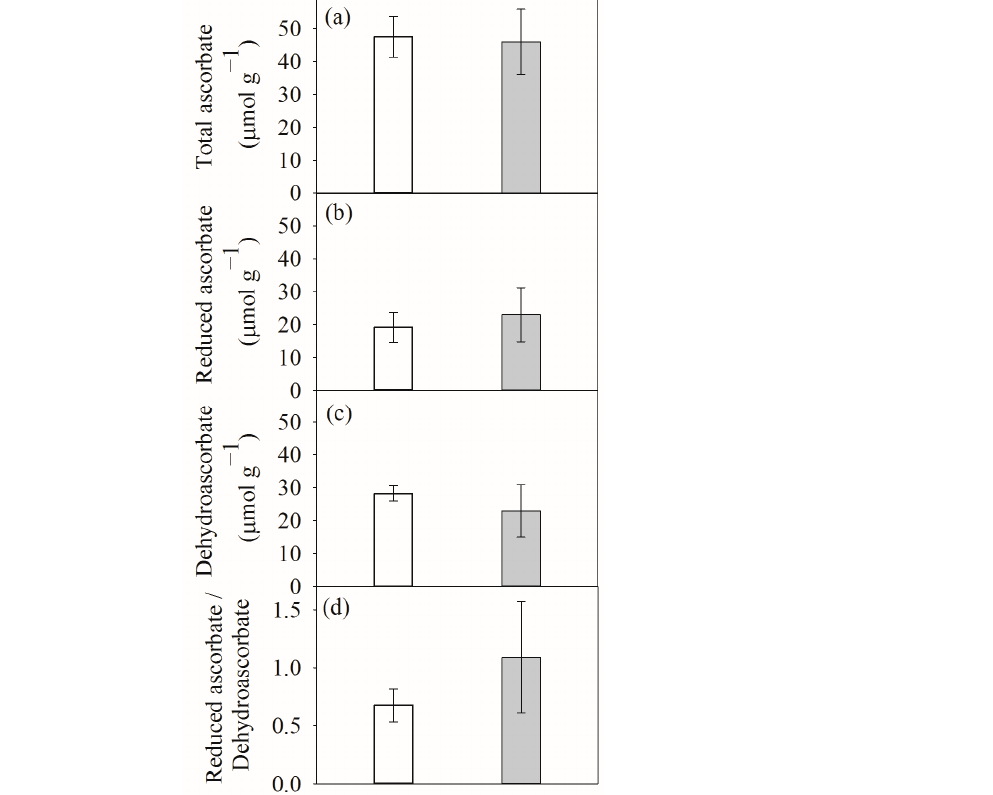
(Figure 6c,d), compared to SW trees, LW trees had 34% lower dehydroascorbate reductase